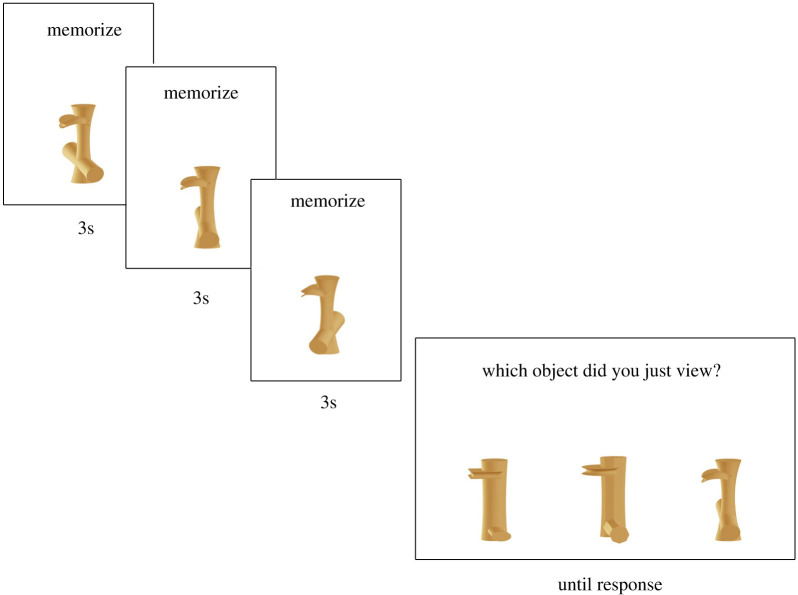
Learning phase for Novel Object Memory Test—Ziggerins. Adapted from Richler et al. [23], used with permission from Dr Isabel Gauthier.